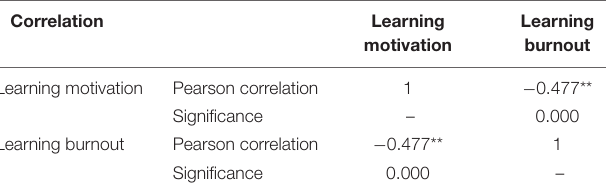
TABLE 1 | Correlation analysis between learning motivation and learning burnout.